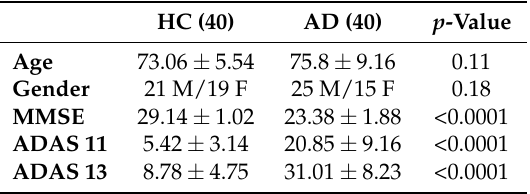
Table 1. Demographic and clinical characteristics of the study participants. For the clinical assessment, the mini-mental state examination test (MMSE), Alzheimer’s disease assessment scale (ADAS) 11 [17] and ADAS 13 [18] scores are reported. According to the t-test statistics, MMSE, ADAS 11 and ADAS 13 are significantly different between healthy controls (HC) and Alzheimer’s disease (AD). For age and gender, the chi-squared test was